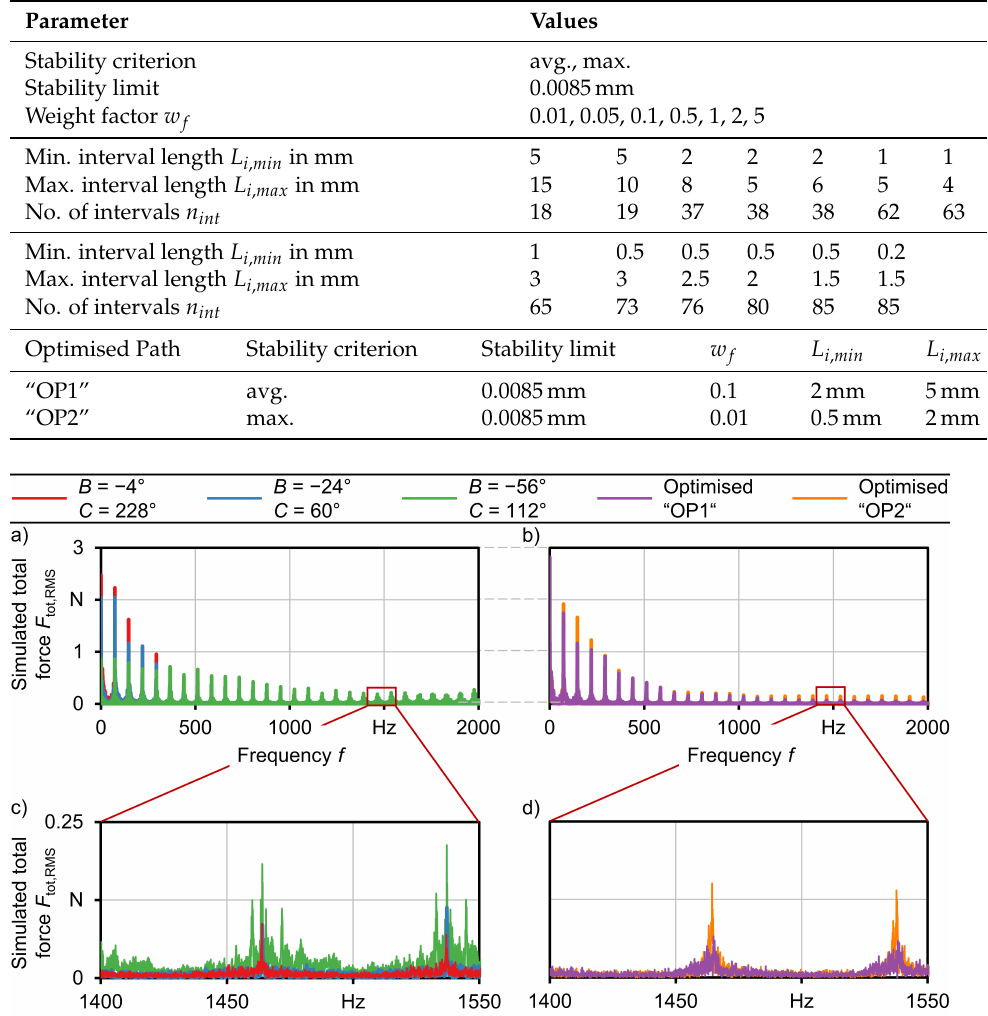
Table 4. Optimisation parameters.